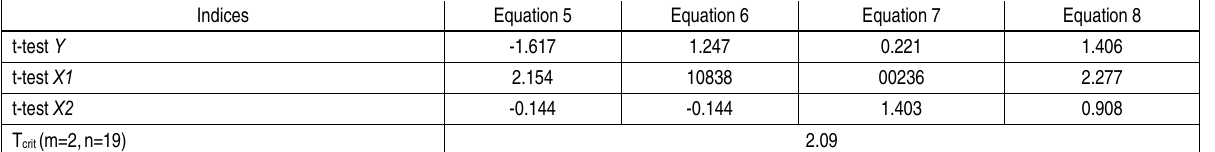
Table 2 (cont.). Pilot parameters of Correlation Regressive Analysis over the period 1997-2015